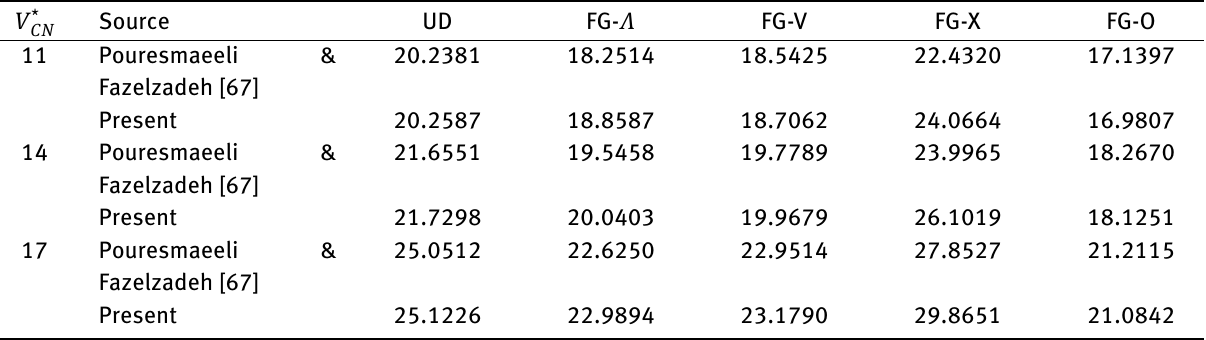
Table 3: Comparison of linear frequency ˜ Ω = Ω ( a 2 / h ) √︀ ρ 0 / E 0 for double curved CNT/PmPV panels ( a/b = 1, a/h = 20, a/R 1 = b / R 2 = 0.5, T